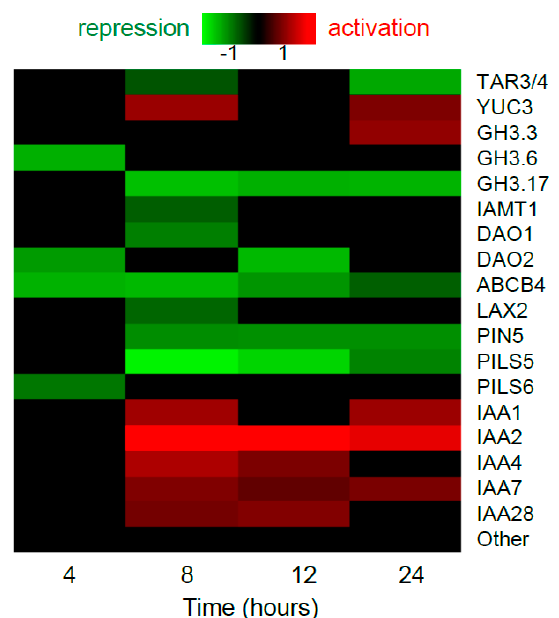
Figure 1. Transcriptional regulation of auxin ‐ related genes by ethylene precursor ACC in Arabidopsis root. The datasets from Harkey et al. [20] were analyzed. Only genes with significant expression changes (Benjamini ‐ Hochberg FDR < 0.05) are shown in the heatmap. We omitted the data for 0.5, 1 and 2 h time points, as there were only few differentially ‐ expressed genes under this criterion. “Other” are the rest of genes from TAA1/TAR, YUC, PIN, Aux/LAX, PILS, TIR/AFB, ARF, Aux/IAA families and auxin ‐ related genes from ABCB, GH3 families.